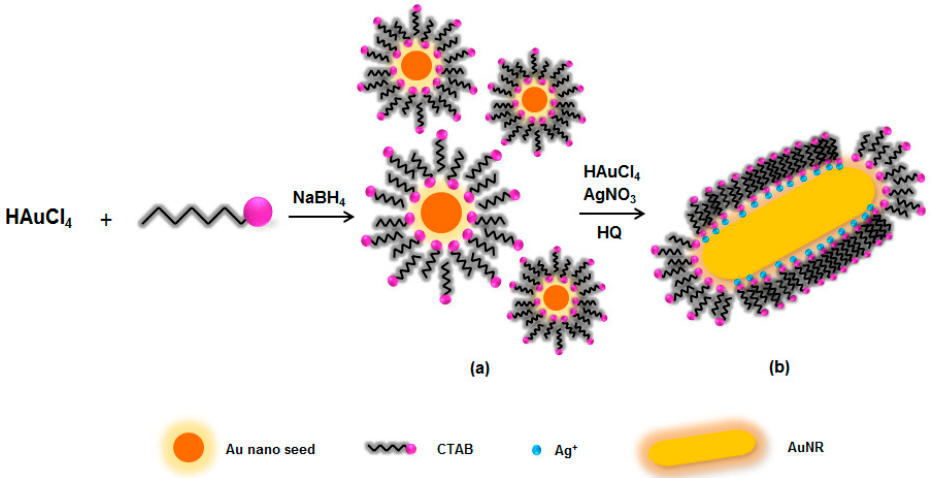
Figure 2. Fabrication process of gold nanorods (AuNRs): ( a ) formation of Au nanoseeds, ( b ) growth of Au nanoseeds into AuNRs. of Au nanoseeds into